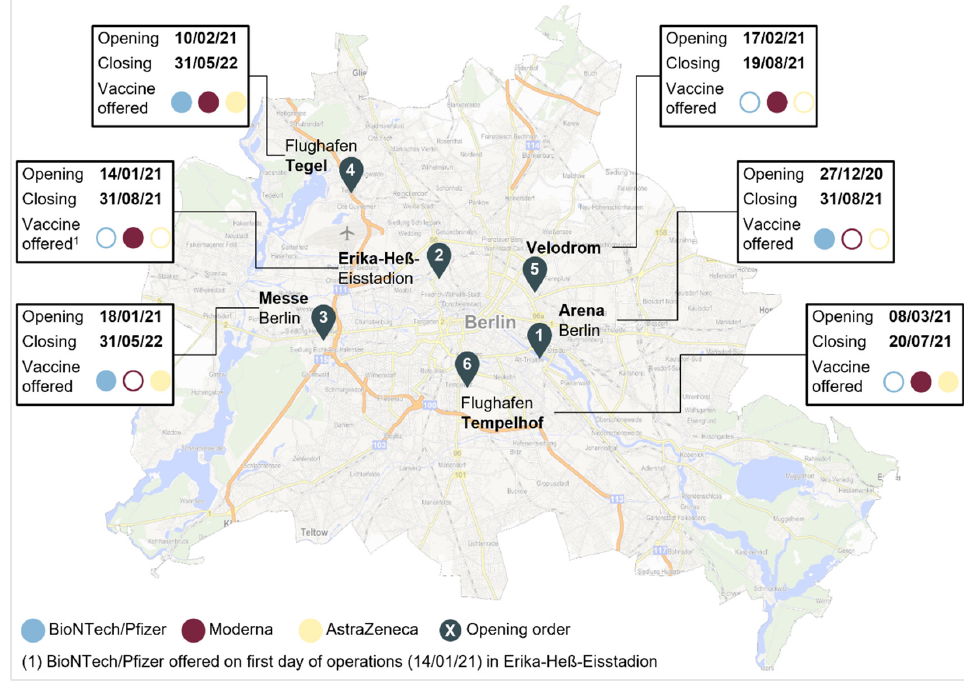
Figure A1. Overview of COVID-19 vaccination centers in Berlin by opening order.